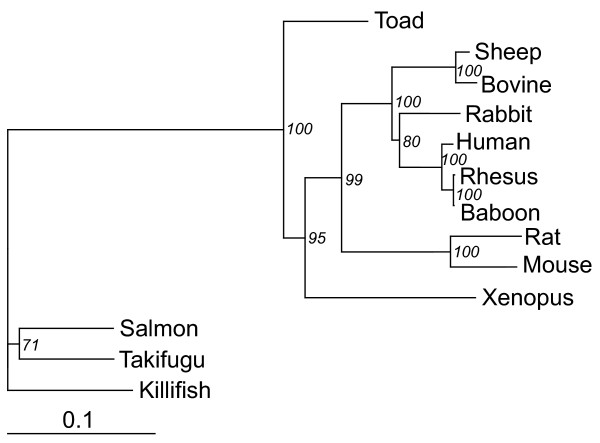
Phylogeny of the CFTR family. Bootstrap values are indicated at corresponding nodes of the tree. Scale bar represents amino acid replacements per site per unit evolutionary time.